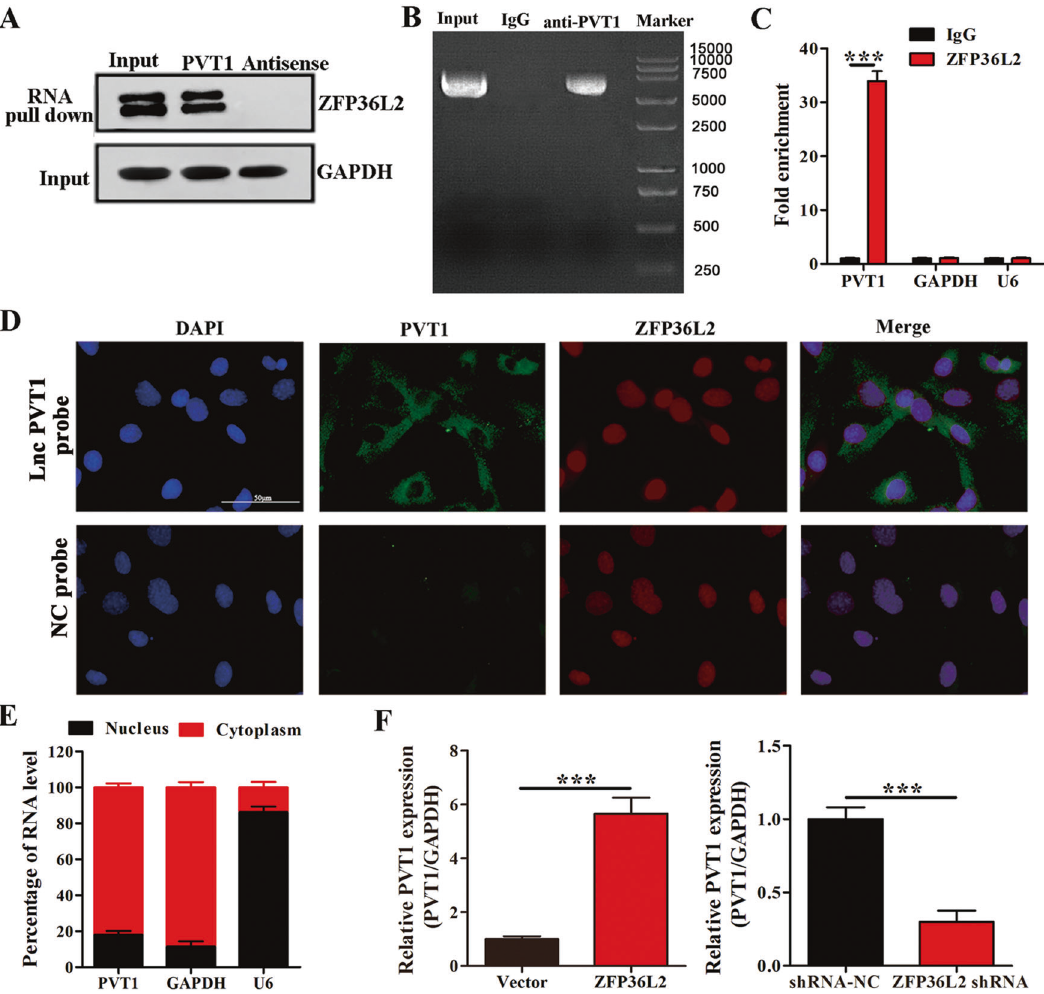
blots from RIP experiments performed using ZFP36L2 or IgG, indicating the expression of PVT1. Quanti fi cation of fold enrichment of PVT1, GAPDH and U6 in ZFP36L2 RIP fractions relative to input RNA is shown ( n = 3). D Representative confocal micrographs from fl uorescence in situ hybridization with probes against PVT1 (green) and ZFP36L2 (red). The nucleus was stained with DAPI (Scale bar = 50 μ m) ( n = 3). E Total percentage of PVT1 RNA in nuclear and cytoplasmic fractions in cardiomyocytes determined by subcellular fractionation ( n = 3). F PVT1 mRNA levels were detected by qRT-PCR in cardiomyocytes expressing shRNA-NC/ZFP36L2 shRNA and Vector/ZFP36L2 ( n = 3). *** P <